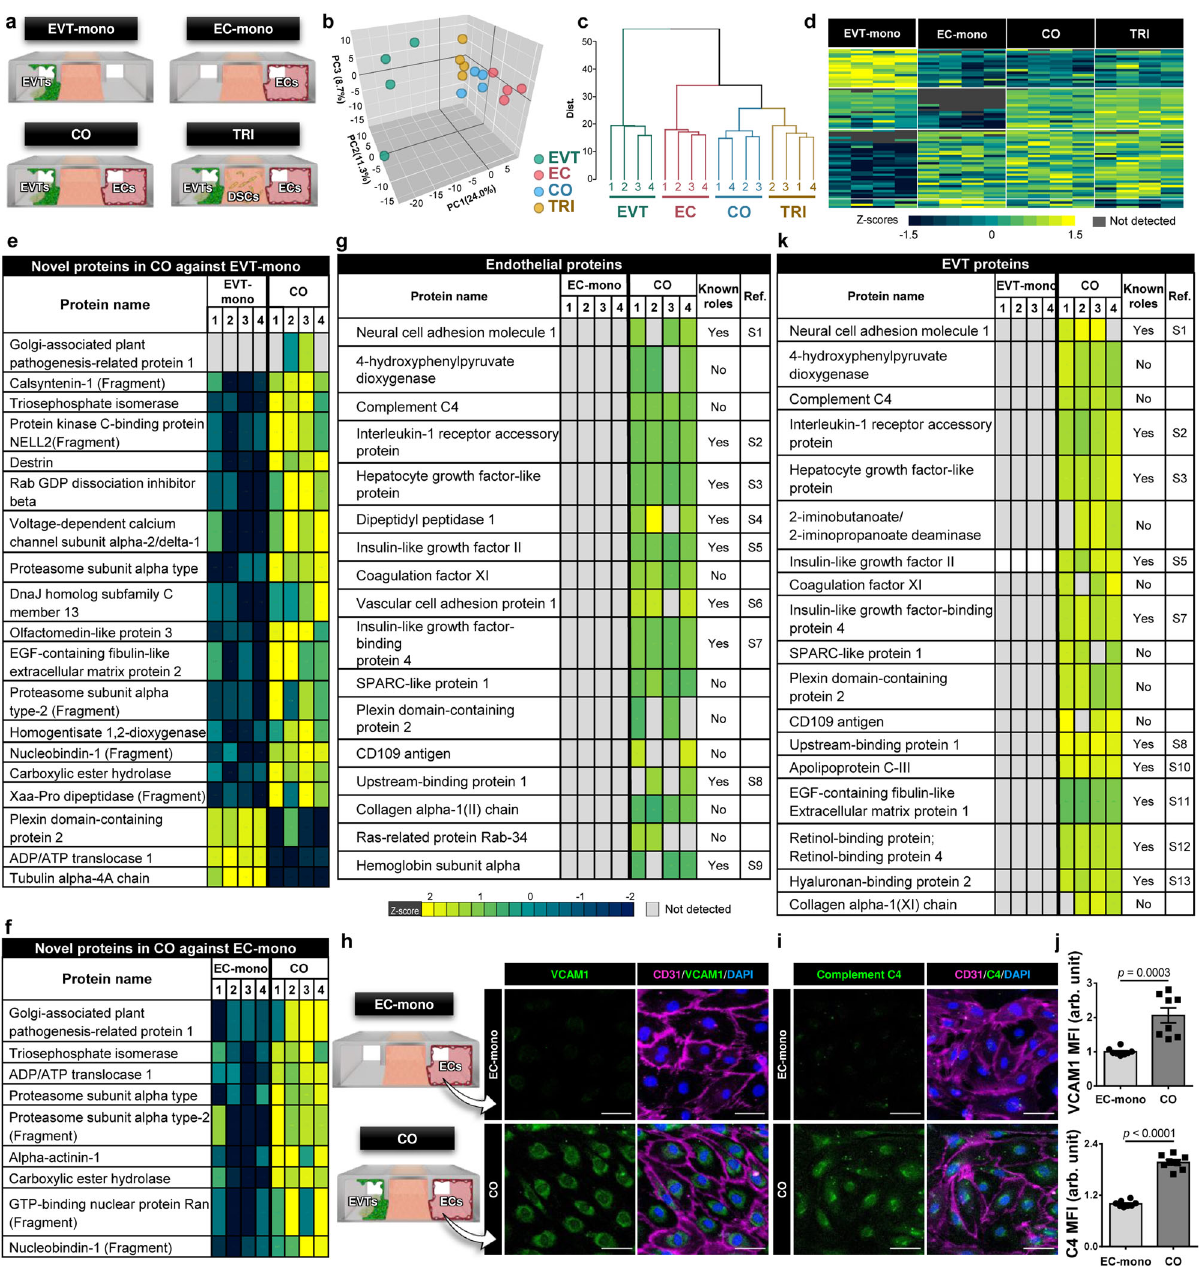
Fig. 6 Secretomic and Proteomic analysis of implantation on-a-chip. a Four different culture conditions investigated in proteomics analysis. b Plots generated by principal component analysis performed across all quanti fi able proteins ( n = 498) from 4 biological replicates for each of the tested conditions. Each data point represents an individual biological replicate. c Heirarchical clustering plot. d Heatmap depicting the human proteins signi fi cantly modulated in abundance in the different tested conditions (one-way ANOVA p < 0.05). e , f 19 and 9 proteins without known function in implantation from the comparison of secretome e between CO and EVT-mono and f between CO and EC-mono, respectively. g 17 uniquely expressed endothelial proteins in the coculture con fi guration of the implantation-on-a-chip, including 8 proteins with unknown function in implantation and placental development. The left- most column named Ref. shows references in Supplementary Information. Immuno fl uorescence of h VCAM-1 and i C4 in the vascular endothelium in the implantation-on-a-chip at Day 6. The representative images are from three independent experiments. Scale bars, 50 μ m. j Quanti fi cation of immuno fl uorescence of VCAM-1 and C4 staining. Data were presented as mean ± s.d. Two-sided t-test ( n = 8 images taken from four independent devices per group). p values are shown on graphs. k 18 uniquely induced EVT proteins in coculture, including 8 proteins with previously unknown roles in implantation/placentation. The left-most column named Ref. shows references in Supplementary Information. Source data are provided as a Source Data fi